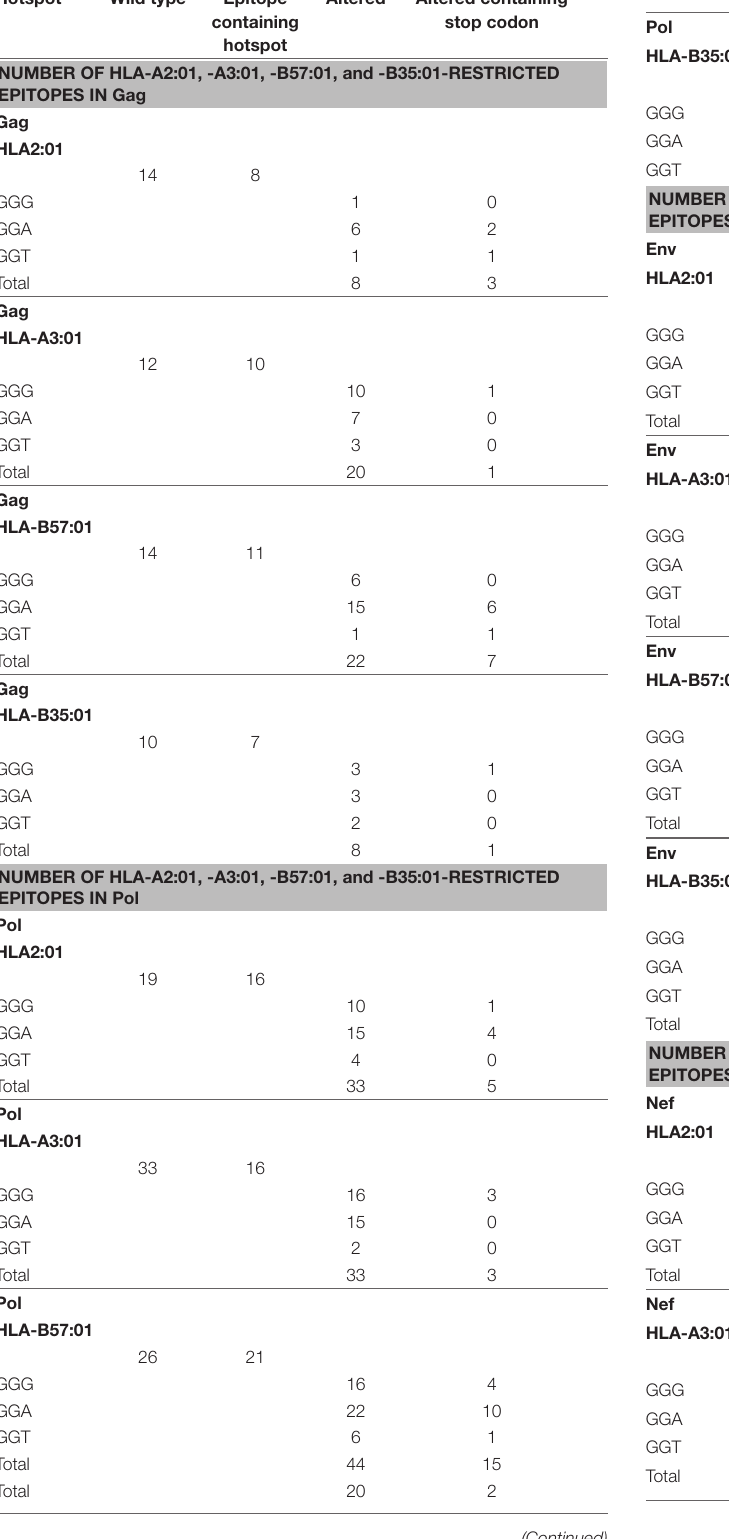
TABLE 1 | Summary of the number of potential CTL epitopes restricted to HLA-A2:01, HLA-A3:01, HLA-B57:01, and HLA-B35:01 for wild-type and A3G-mediated mutated Gag, Pol, Env, and Nef proteins. Hotspot